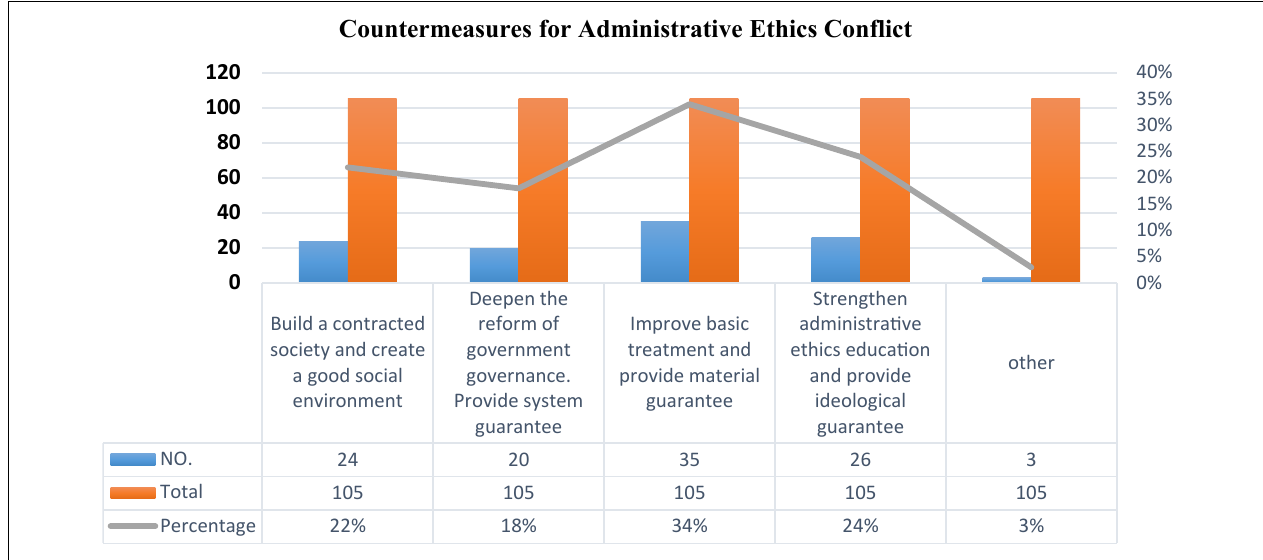
FIGURE 4 | Countermeasures for administrative ethics